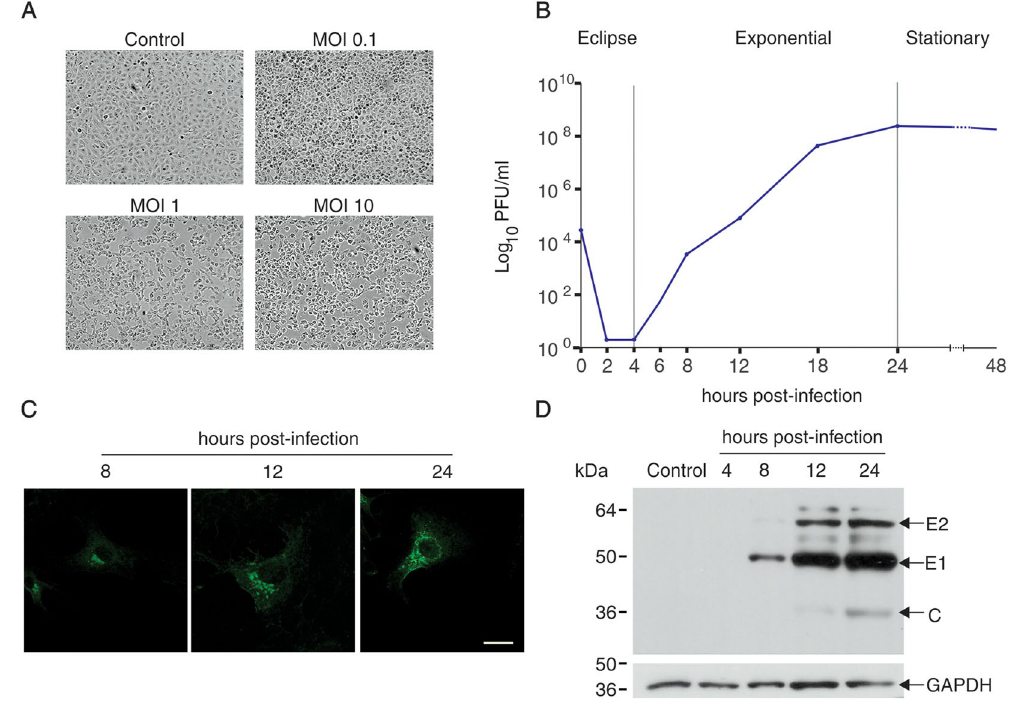
Figure 1. PIXV replication cycle in Vero cells. ( A ) PIXV induces modifications in the morphology of Vero cells at different MOI (0.1, 1 and 10) after 24 h of infection. Vero cells monolayer mock-infected or infected at MOI 0.1 (top) and MOI 1 or 10 (lower panel of the figure) were imaged with phase contrast microscopy at low magnification. The cytopathic effect (CPE) is observed from MOI 0.1, with the maximum disruption of the monolayer at MOI 10 (arrows). ( B ) PIXV growth curve in Vero cells. Monolayers were infected with MOI 0.1 and culture media were collected at different times (2, 4, 6, 8, 12, 18, 24 and 48 h.p.i.) and then assayed